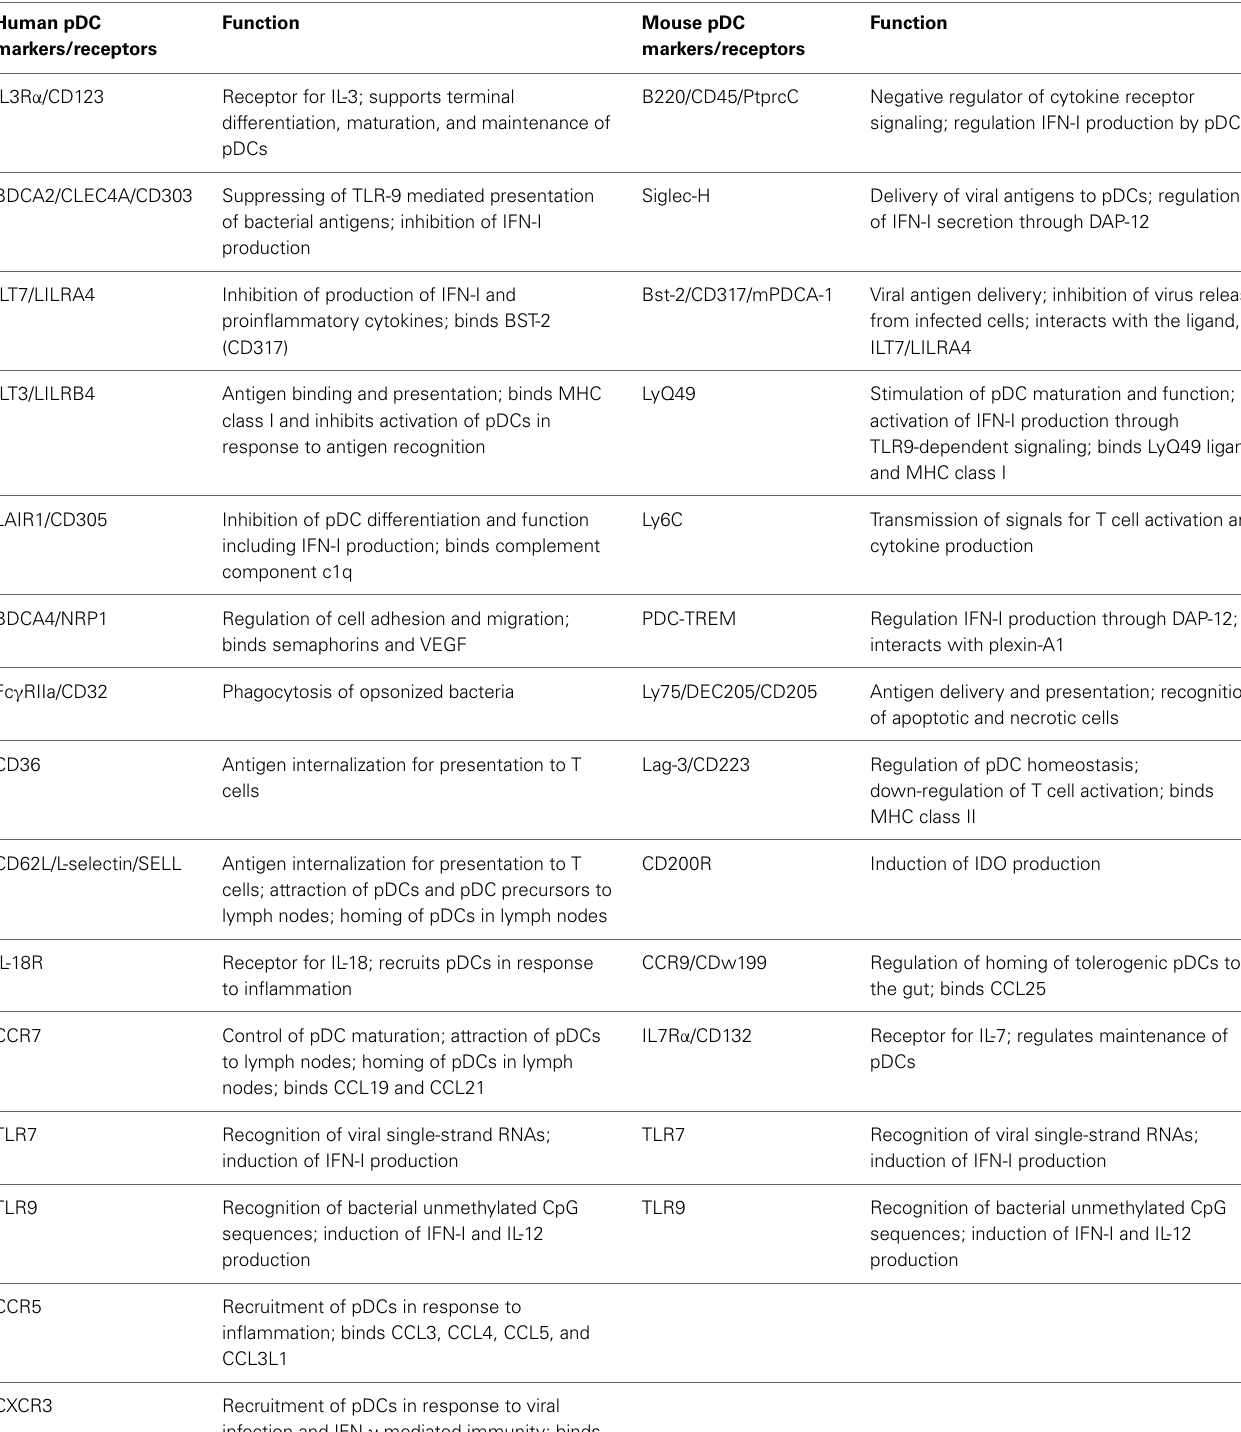
Table 2 | Surface markers and receptors that distinguish human and mouse pDCs from cDCs. Human